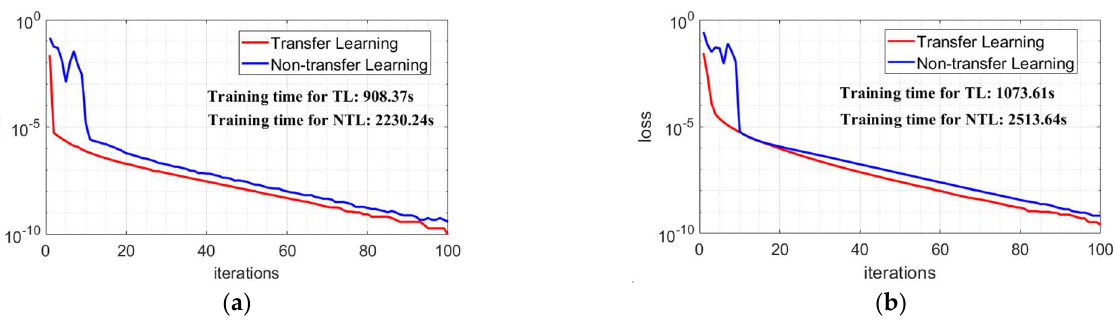
TL denotes the transfer learning method and the NTL denotes the non-transfer learning method. ( a )